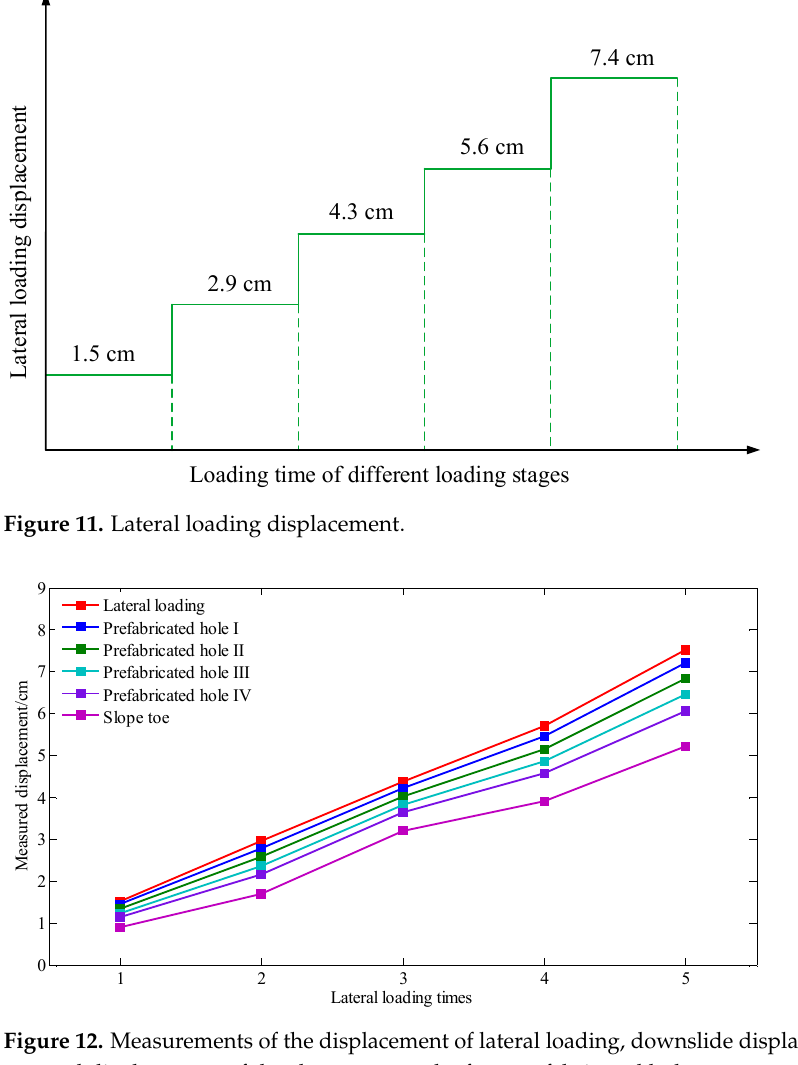
Figure 12. Measurements of the displacement of lateral loading, downslide displacement of the slope toe, and displacement of the slope mass at the four prefabricated holes.